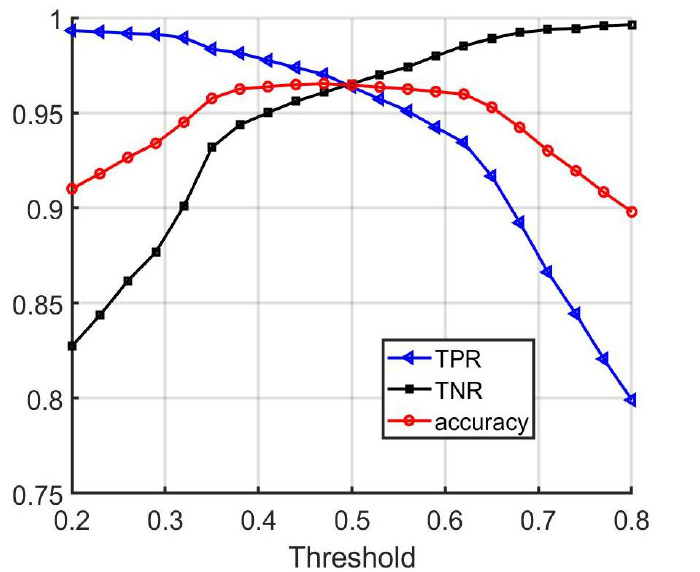
Figure 9. Performance of decision fusion by averaging.